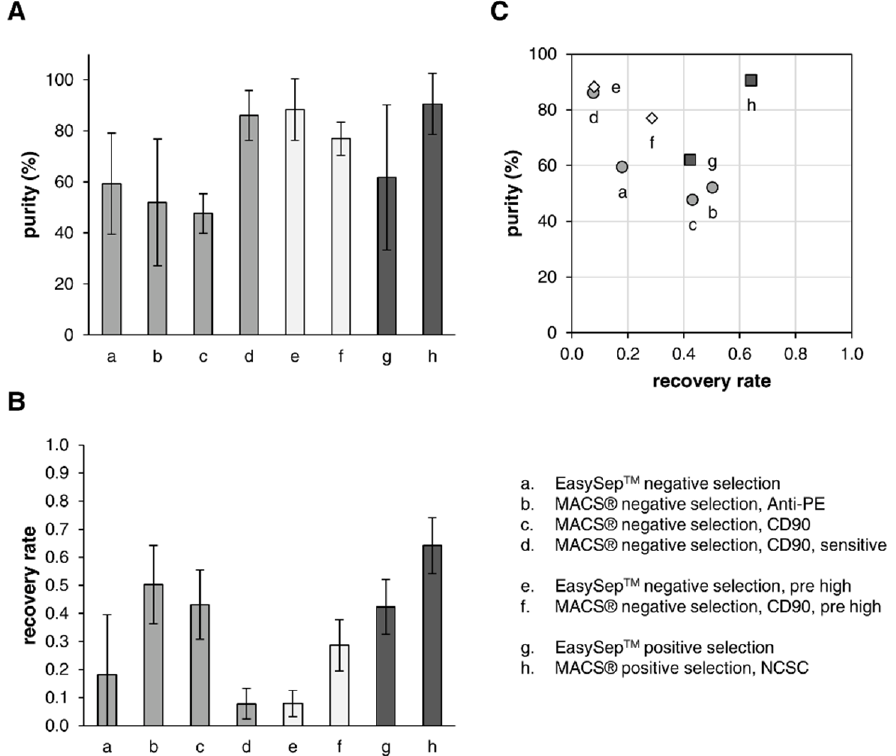
Figure 6. Overview of purity and recovery of DSCs after the individual selection methods. ( A ) Purity. Frequency of DSCs in the purified fraction after separation determined via flow cytometry analysis of NGFRp75. Values are presented as mean ± SDs. ( B ) Recovery rate. Ratio of the absolute number of DSCs in the purified fraction after separation to the absolute number of DSCs in the pre sample. Values are presented as mean ± SDs. ( C ) Plot of recovery rate ( x -axis) versus purity ( y -axis) of the individual selection methods. Sample size: a. n = 5; b. n = 3; c. n = 2; d. n = 3; e. n = 3; f. n = 2; g. n = 6; h. n = 13.